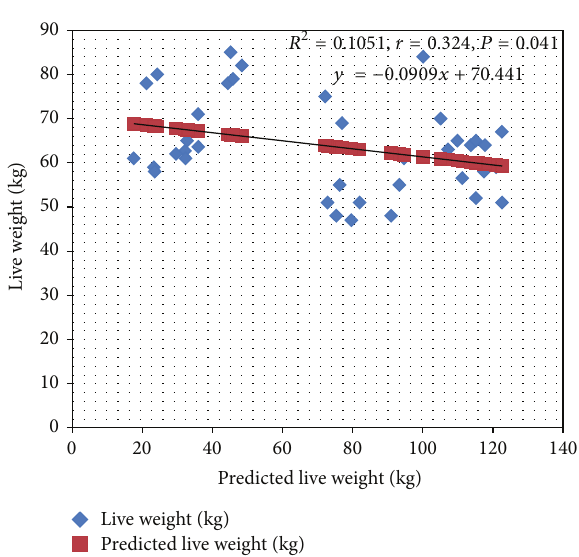
Figure 3: External validation of model 1 with pigs from differently managed environment ( 𝑛 = 40